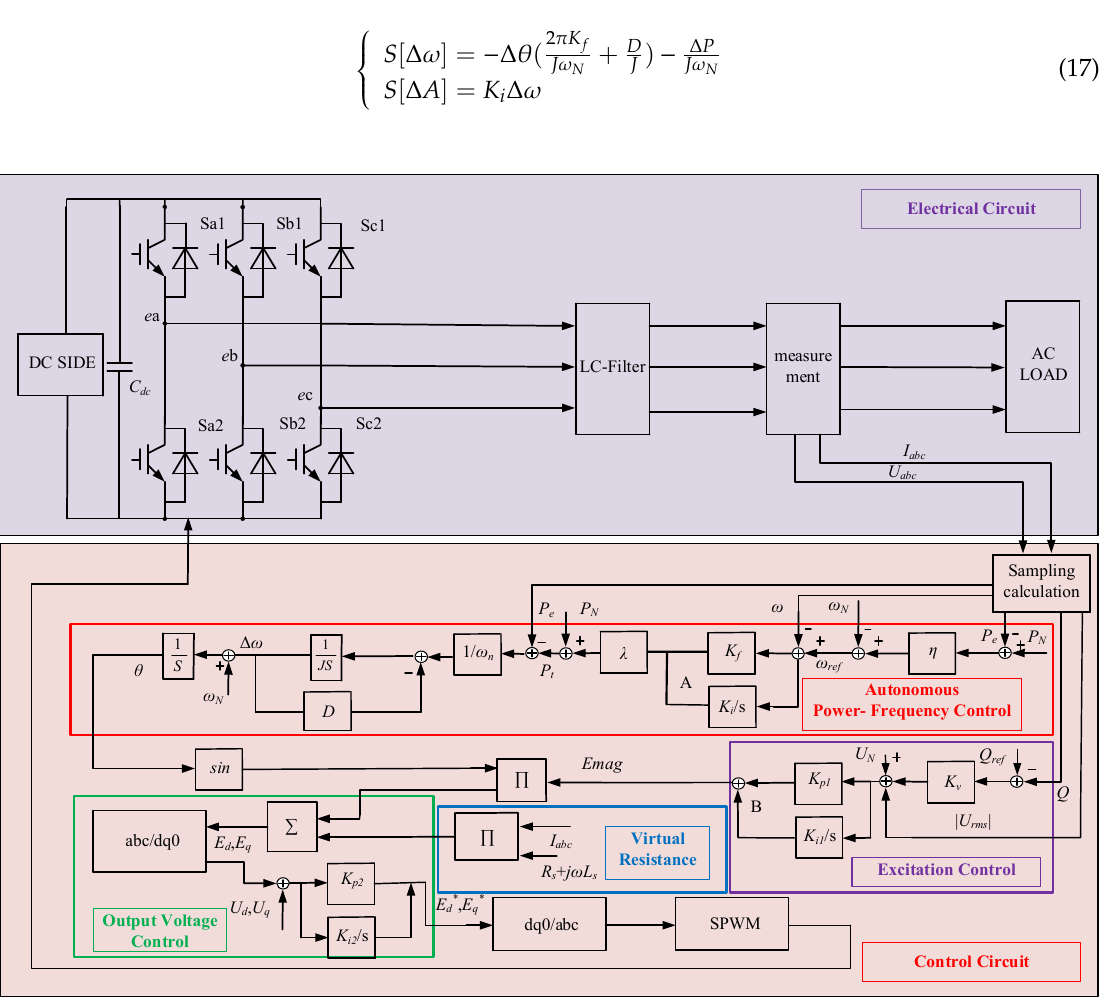
Figure 6. Microgrid with single virtual synchronous generator (VSG).